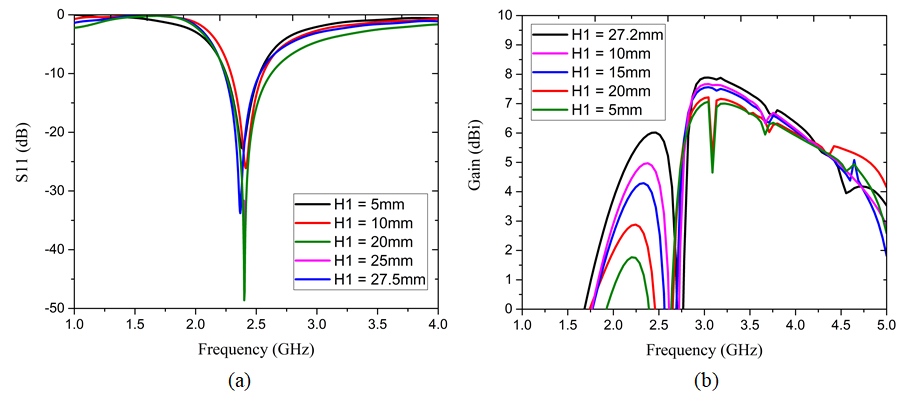
Figure 11. Comparison of far-field pattern without/with AMC-MS structures (layers) in the proposed antenna configuration for: ( a ) radiation pattern, ( b ) boresight gain without/with AMC-MS structures (layers), and ( c ) 3D radiation pattern at 2.45 GHz and 4.0 GHz.